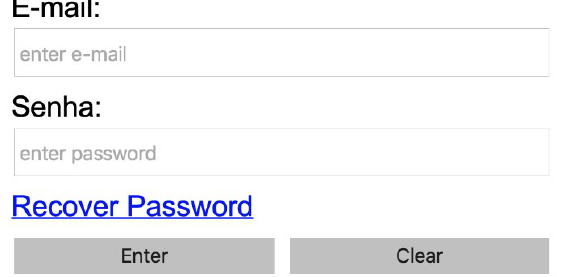
Figure 14. Visualization of the HTML code generated by the getMainObjects function returning a login Creating a label tag for each form input also improves the site accessibility. Figure 13 also shows the grid property configuration for the form object. It is used to position the elements inside the form. This property must receive a matrix, where each line represents a new line in the layout, and each line value represents the position of the corresponding form element. If a line contains only one element the square brackets can be omitted. Each form element is represented by an integer number, from 0 to the number of elements in the form minus 1. The order of the components in the grid property must be ascending (from left to right and up to bottom), because the order of the tags in the HTML must be the same shown in the screen, avoiding accessibility issues. The Acceasy doesn’t add more HTML tags to implement the position of the elements in the form. In the current version, the Acceasy also provides a ready navigation menu component. This element supports navigation with the keyboard, using the tab and arrow keys. It also adjusts its functioning to provide a better user experience when accessing the page in a device with a screen less or equal 800 pixels. Figures 15 , 16 , 17 and 18 show an example. The function getMenuColors can be implemented to personalize the component colors (check details of it in the documentation).